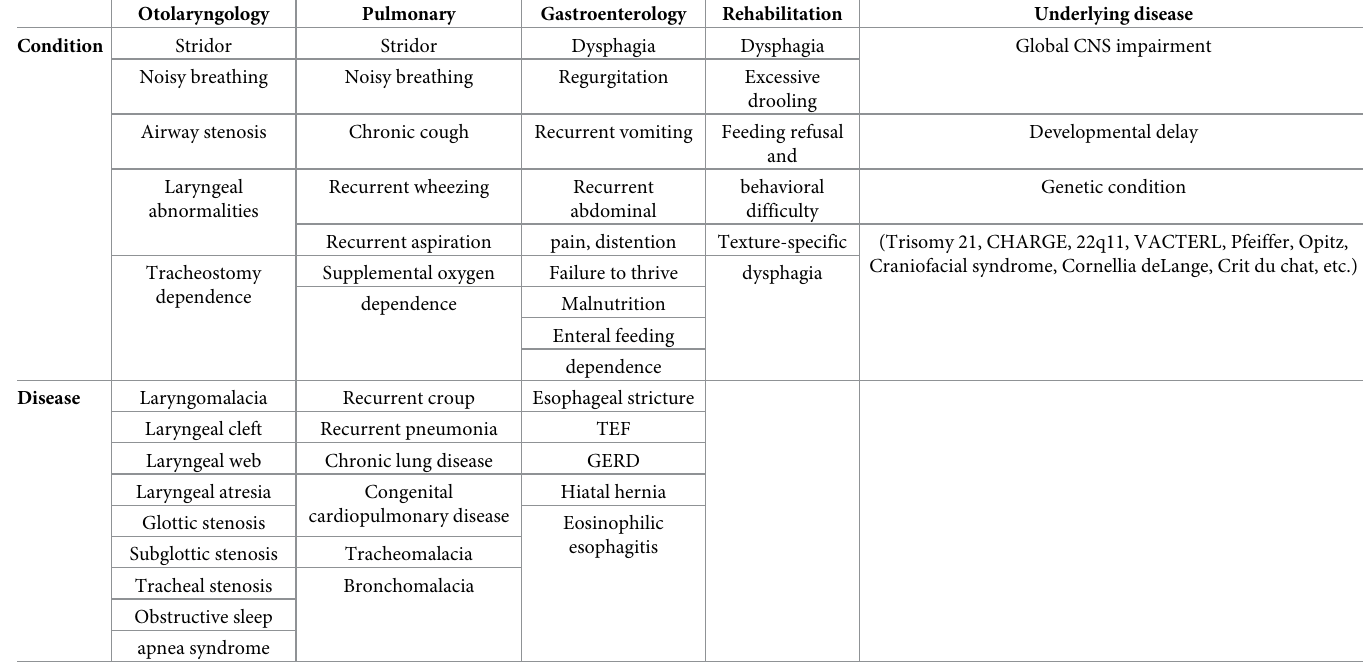
Table 1. Inclusion criteria of the aerodigestive